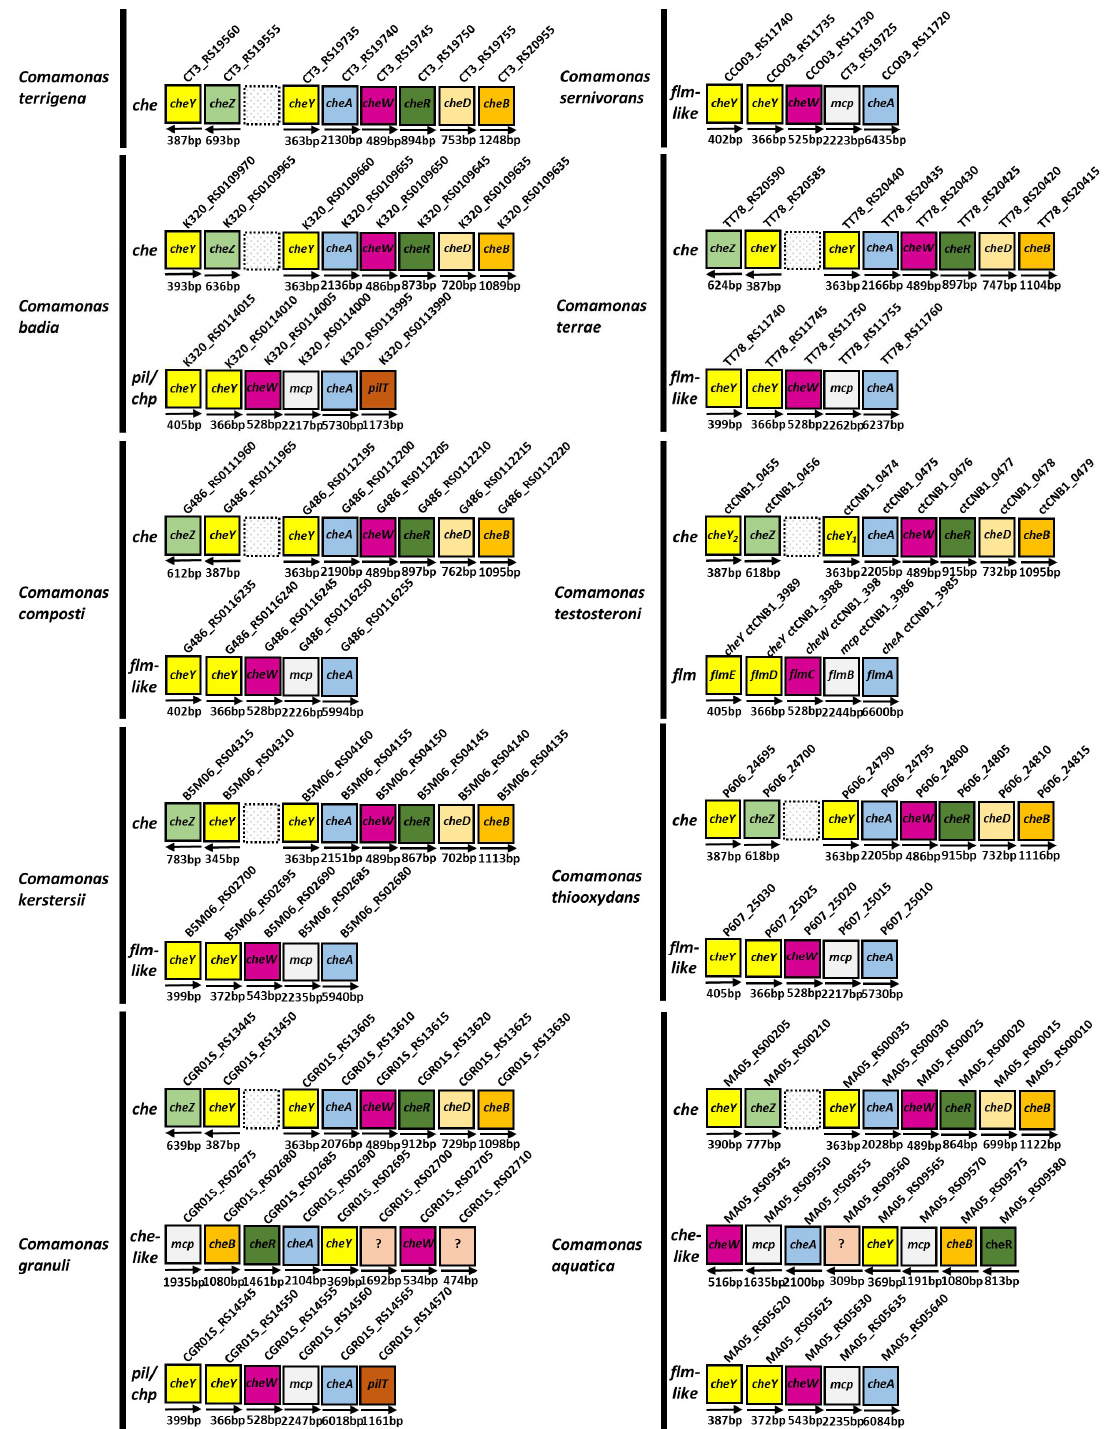
Figure 4. Data-mining of che and che-like gene clusters in C. testosteroni and other Comamonas genomes. There are in total 11 Comamonas genomes in publically available databases. Except for C. nitrativorans (IMG Genome ID: 2574180442), in which there was no che or che-like gene cluster, the che and che-like gene clusters of the other 10 Comamonas genomes were shown. GenbBank IDs are BCNR01000016.1 ( C. terrigena ); CP021455.1 ( C. serinivorans ); AXVM00000000.1 ( C. badia ); BCNT01000000.1 ( C. terrae ); AUCQ01000000.1 ( C. composti ); CP001220.2 ( C. testosteroni ); CP020121.1 ( C. kerstersii ); AWTO01000000.1 ( C. thiooxydans ); BBJX01000000.1 ( C. granuli ); and CP016603.1 ( C. aquatica ). The lengths of rectangles are independent of the lengths of gene sequences.